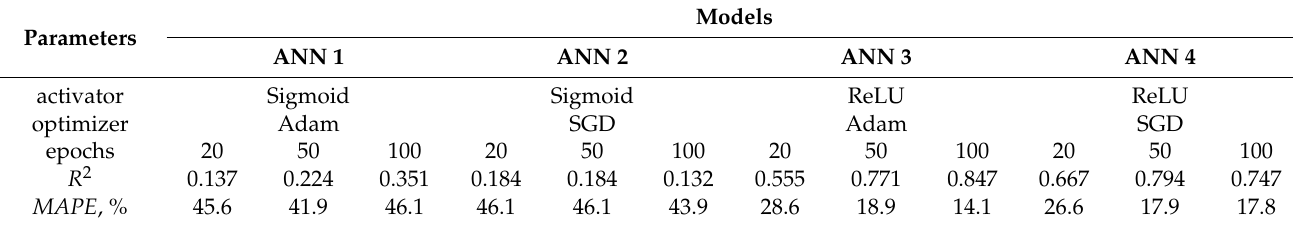
Table 3. Comparison of the ANN models